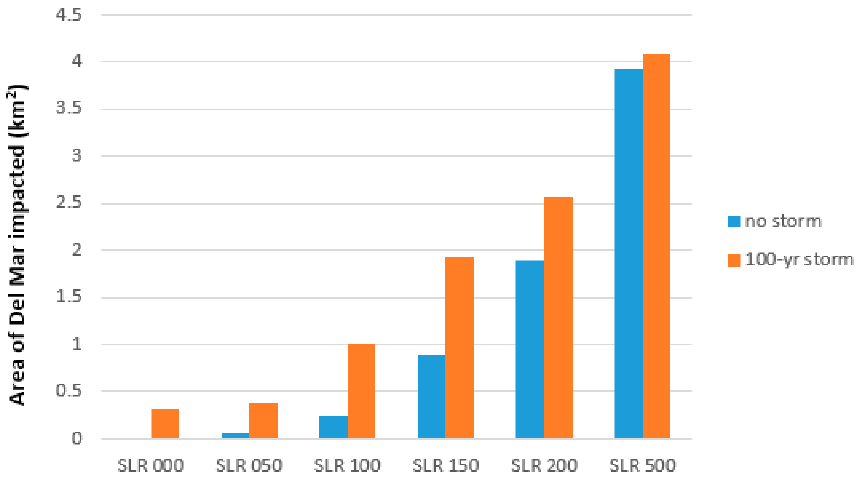
Figure 12. Area of projected flooding impacts for Del Mar for various SLR considering background conditions (no storm) and a 100-year storm.